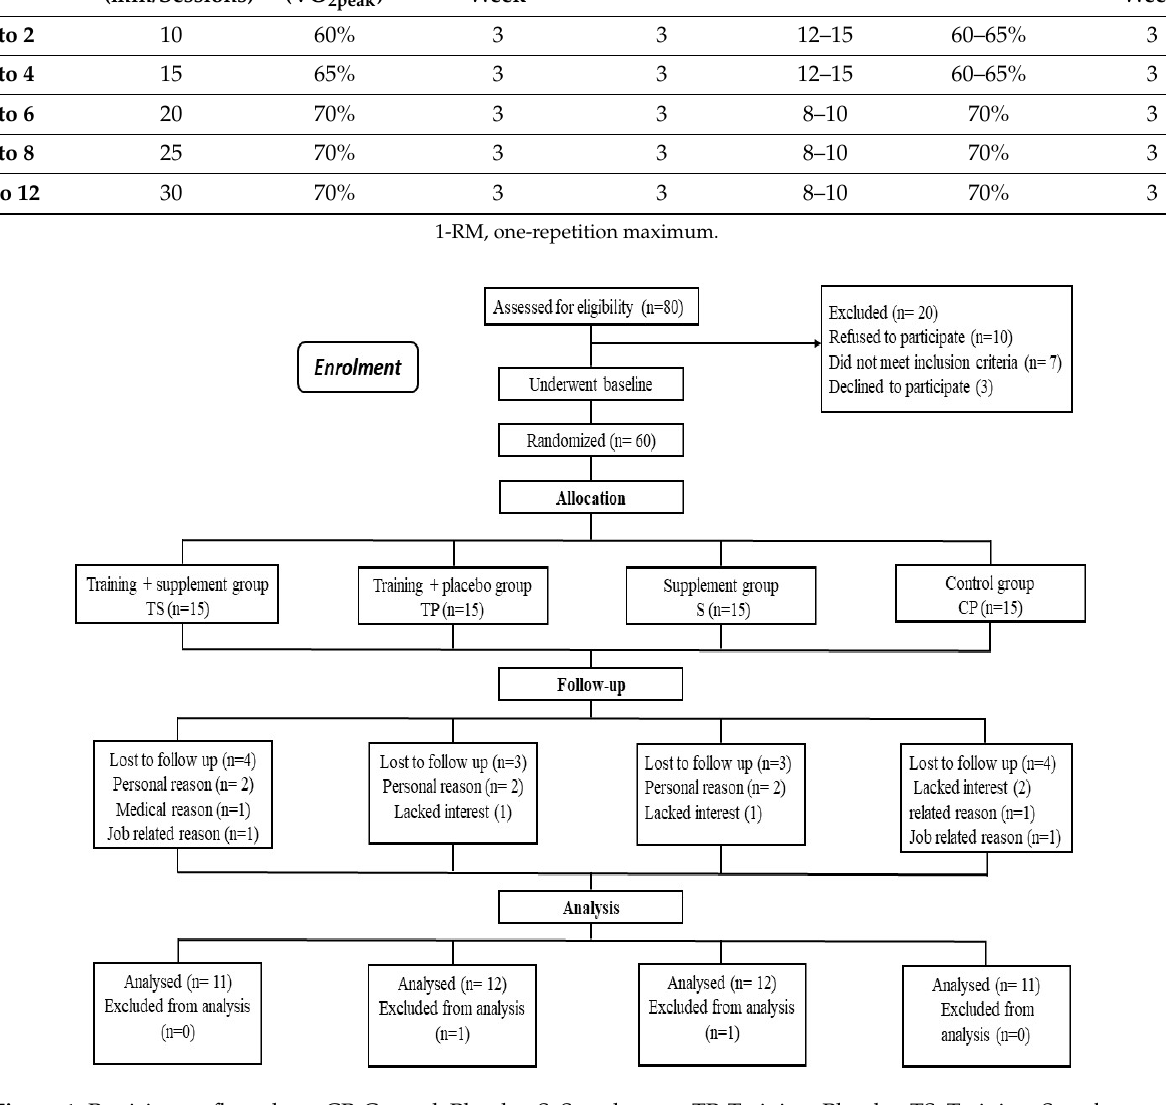
Figure 1. Participants flow chart. CP, Control–Placebo; S, Supplement; TP, Training–Placebo; TS, Training–Supplement.